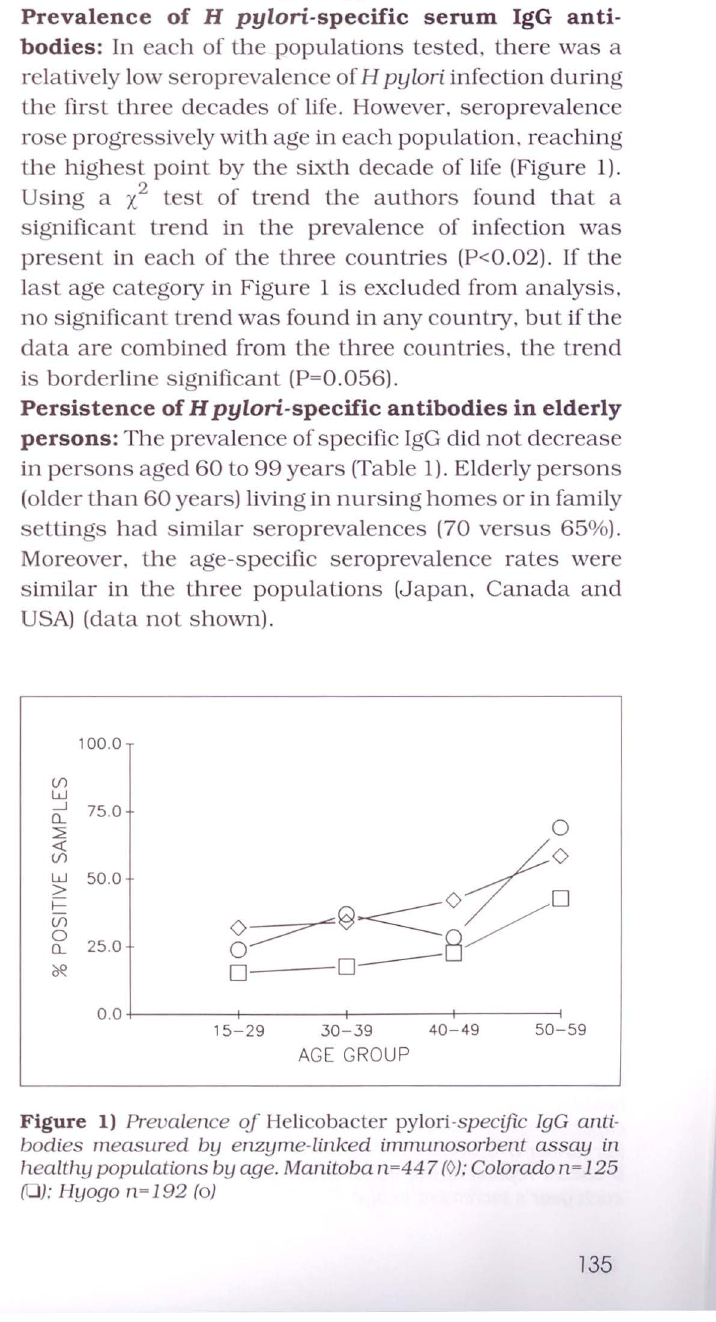
Figure 1) Prevalence of Helicobacter pylori-specific IgG anti bodies measured by enzyme-linked immunosorbent assay in healthy populations by age. Manitoba 11=44 7 (OJ: Colorado n= 125 (OJ: Hyogo n= 192